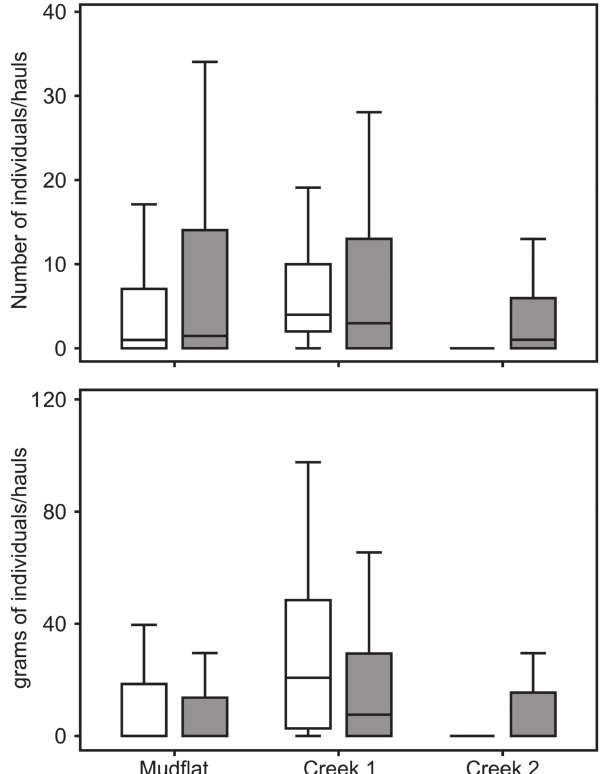
Fig. 2. Box-plot of spatial and temporal variation of number of individuals (CPUE average ±SE) and Biomass (±SE) of A. brasiliensis collected Mamanguape river estuary in Brazil. Bold lines indicate medians, hinges indicate the 25 th and 75 th percentiles, whiskers indicate the largest and smallest observation within a distance of 1.5 the box size. White bar= Wet season and Dark Gray bar= Dry